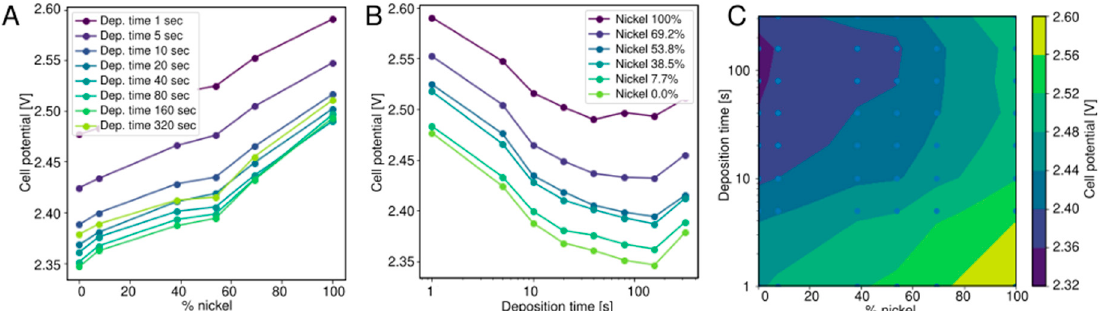
Figure 9. ( A , B ) Univariate plots after removal of outliers. ( C ) Contour plot showing cell potential variation with nickel/iron generator power ratio and deposition time. The dots are the locations of the experimental data points.